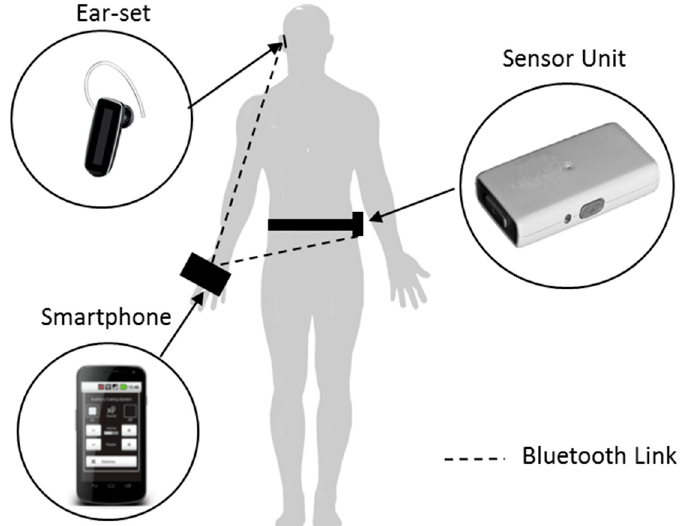
Figure 5. Illustration of user wearing the auditory cueing system, developed by Sama et al. Wireless Samsung (Samsung Group. Seocho District, Seoul, South Korea) HM3500 ear-set, a sensor unit around the user’s waist and a smartphone (Samsung Galaxy Nexus) with auditory cueing application was worn on-body. The smartphone connected to the ear-set and sensor unit over a Bluetooth classic communication